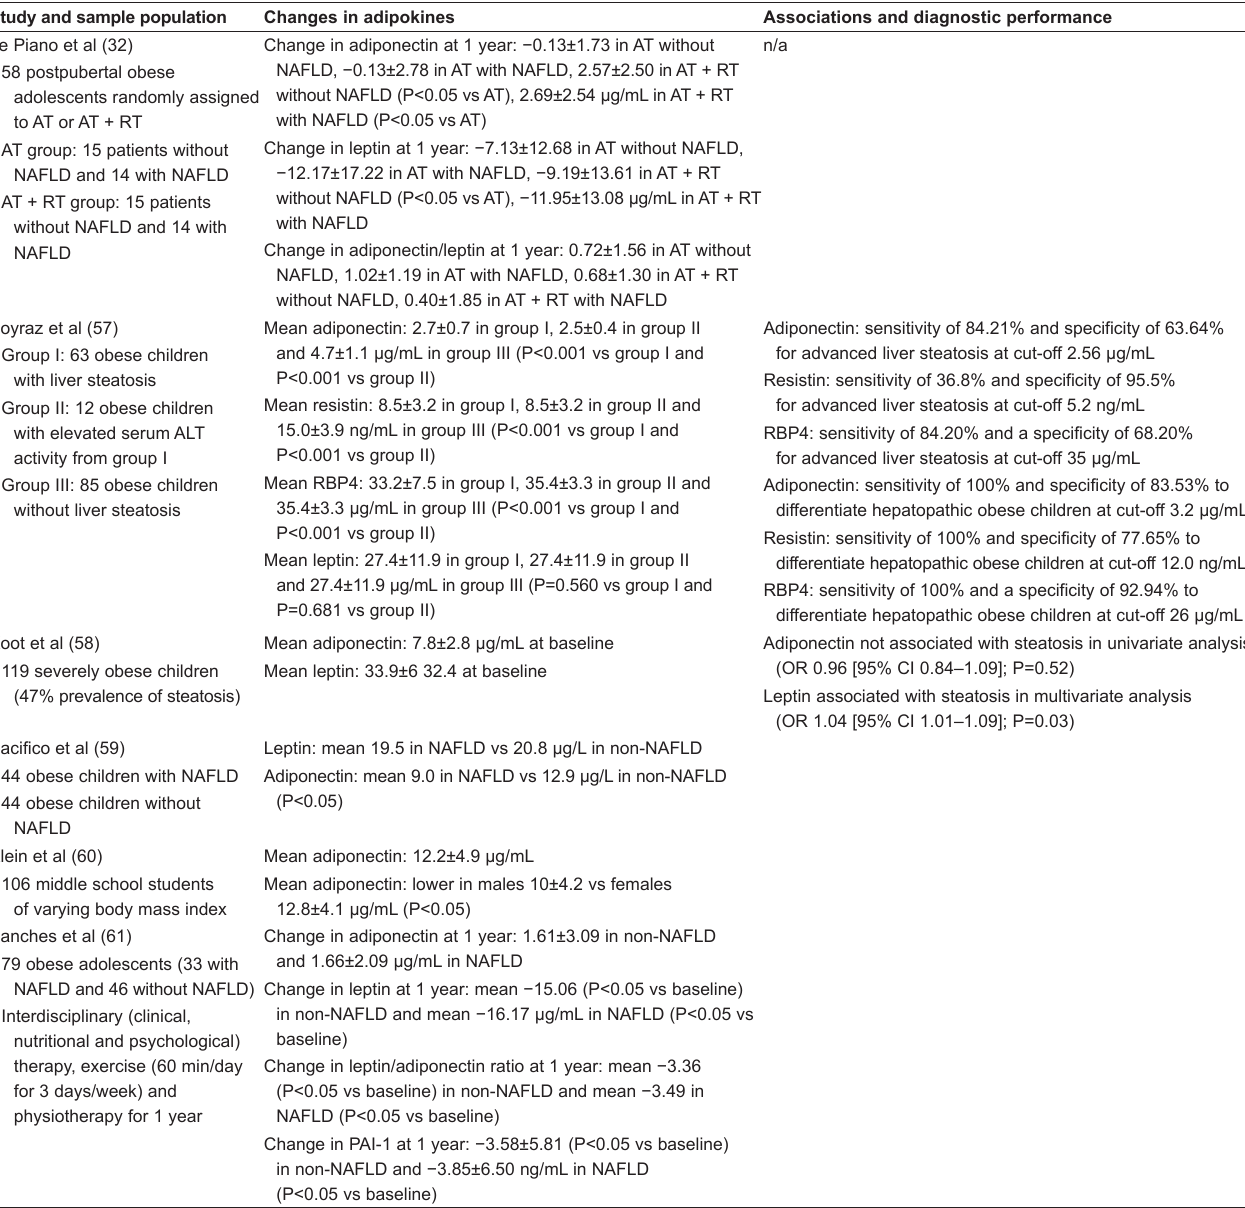
TABlE 3 Adipokine levels in children and adolescents Study and sample population Changes in